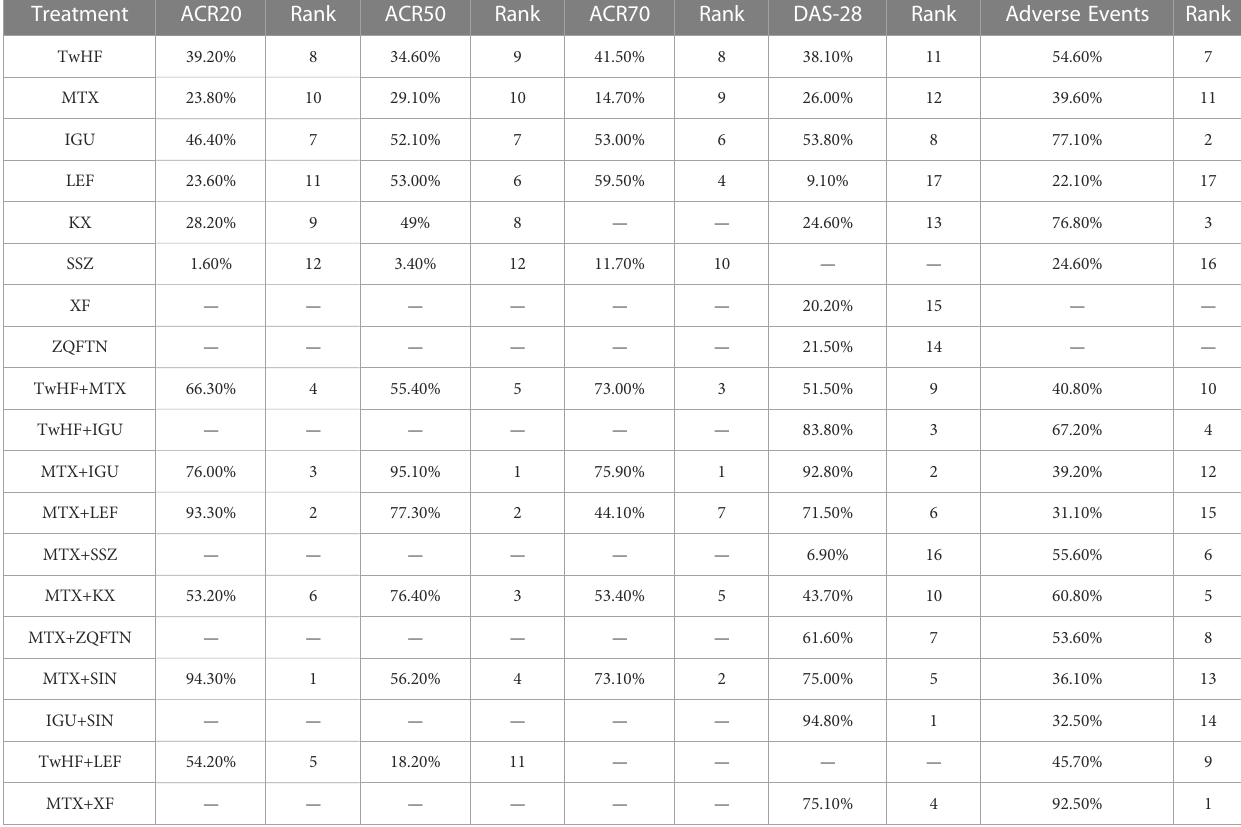
TABLE 1 The SUCRA values of each